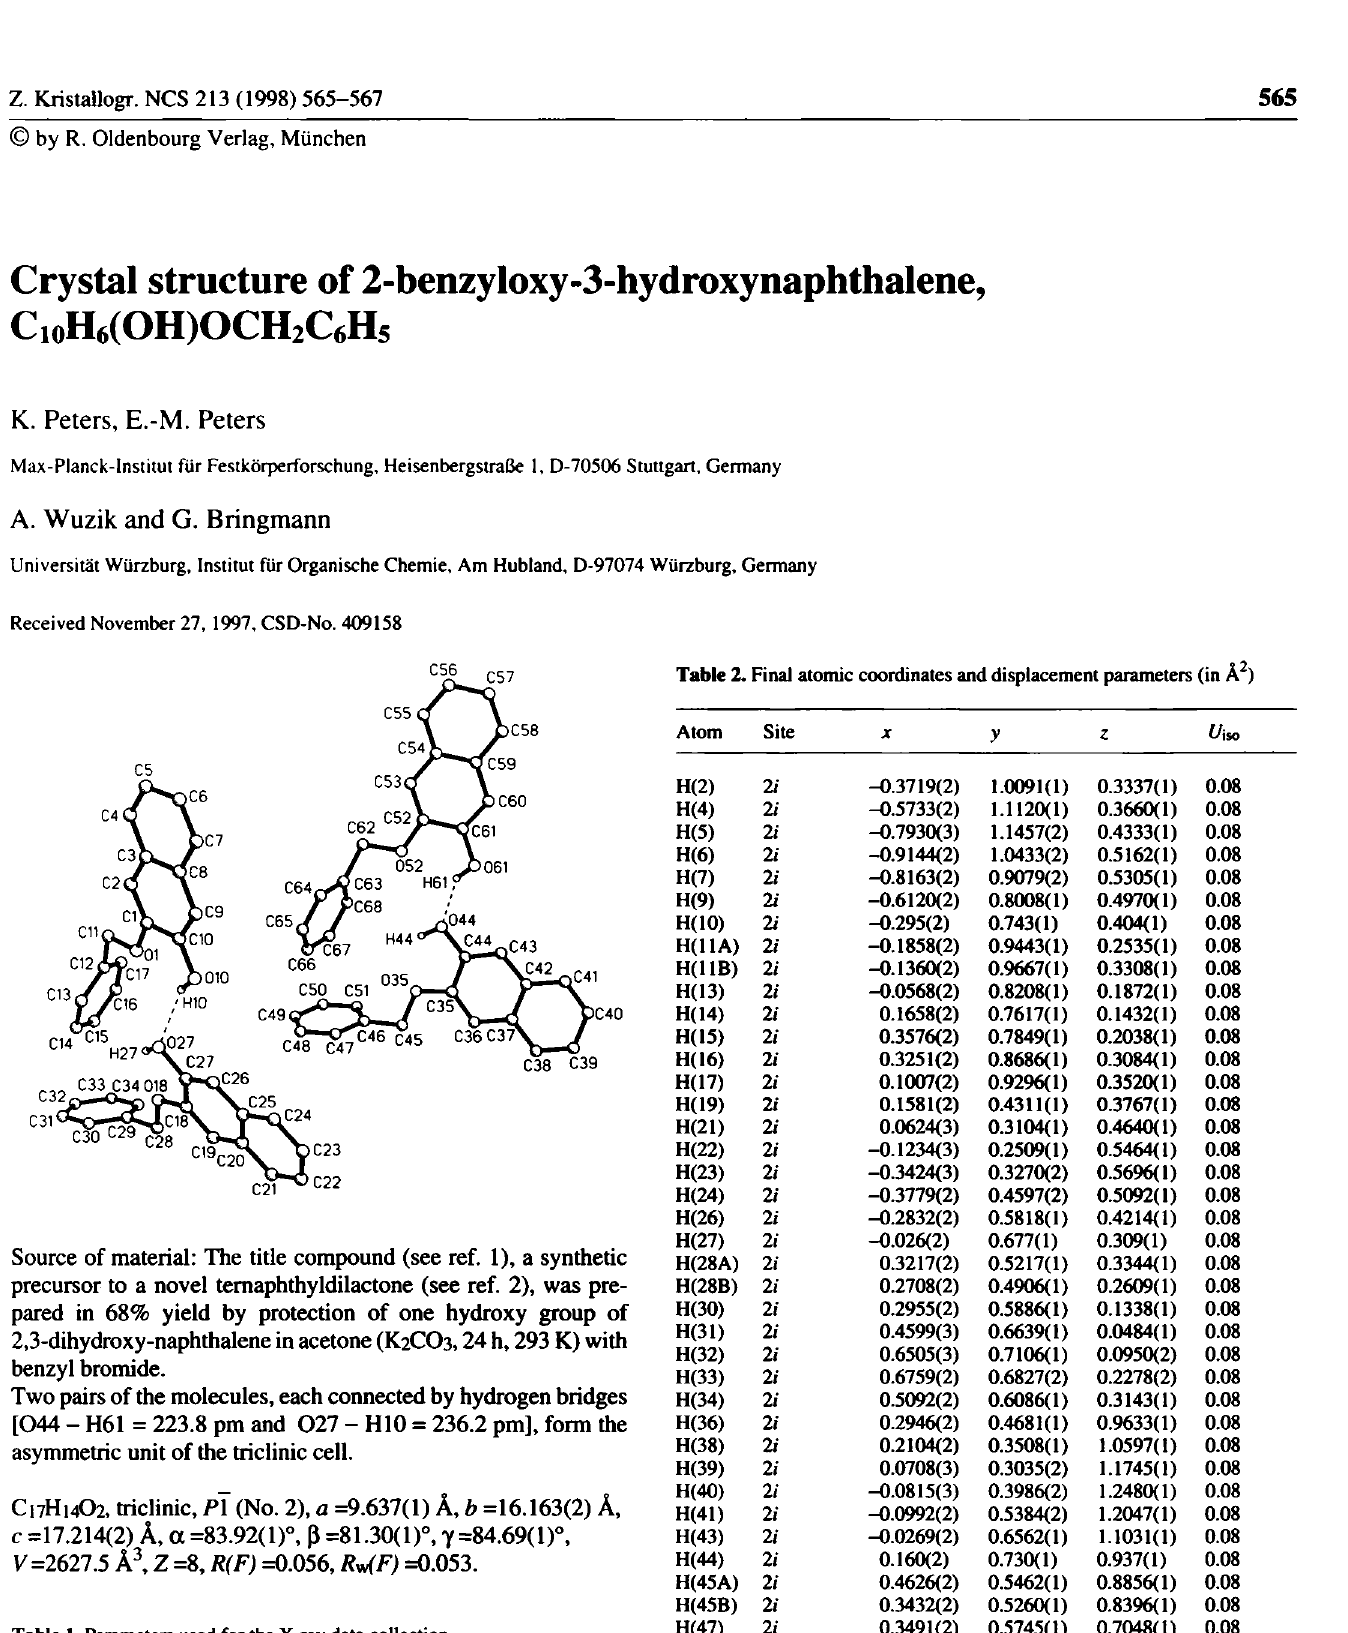
Table 1. Parameters used for the X-ray data collection